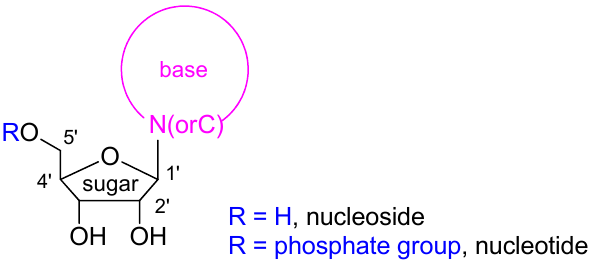
Figure 2. General molecular structure of N- or C- nucleosides/nucleotides.